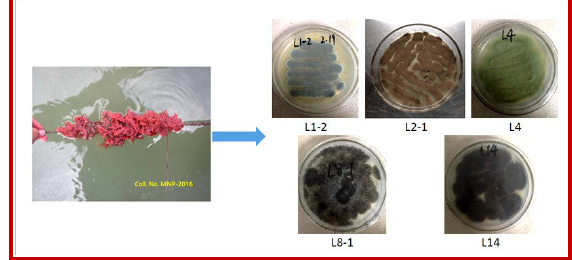
Figure 1: Five symbiotic strains from Reniera japonica MNP-2016